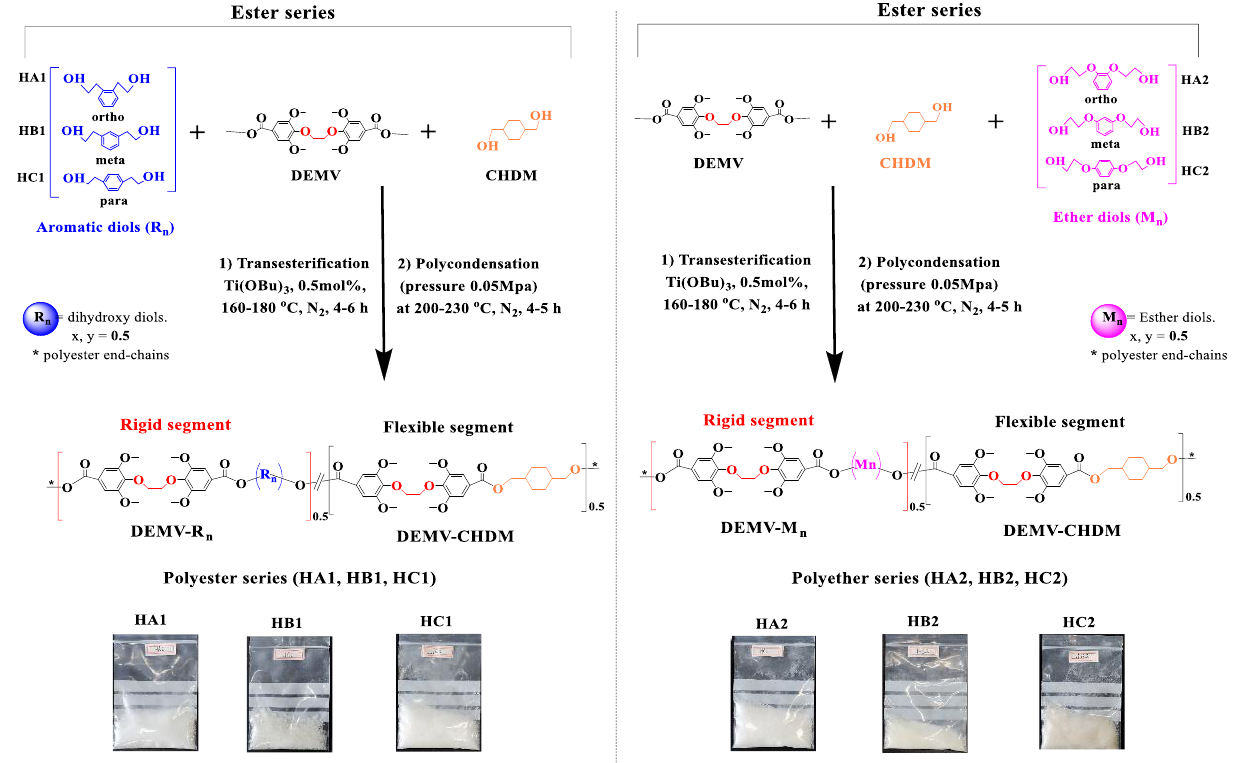
Figure 4. Schematic route for the preparation of poly(ether-ester)s: polyester series: HA1, HB1, and HC1; polyether series: HA2, HB2, and HC2, respectively. Table 1. Summary of synthetic conditions and molecular weight results for